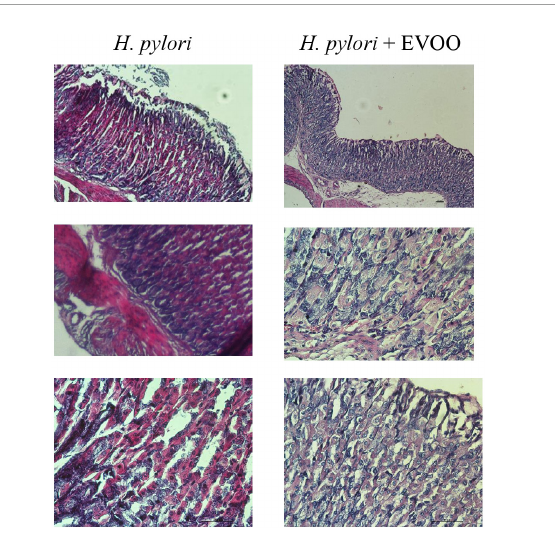
FIGURE8 Hematoxylin–Eosin stain of Helicobacter pylori group and H. pylori and treatment group at 30 days. Significantly damaged tissue is observed with many blood vessels in gastric mucosa from the H. pylori group. At 30 days, significantly damaged tissue is observed with the presence of a large number of blood vessels. The mucosa of animals infected with H. pylori and treated with EVOO shows morphological characteristics similar to those of normal and EVOO mucosa. HP + EVOO group shows a cytoprotected gastric mucosa. Scale bar: 40 µ